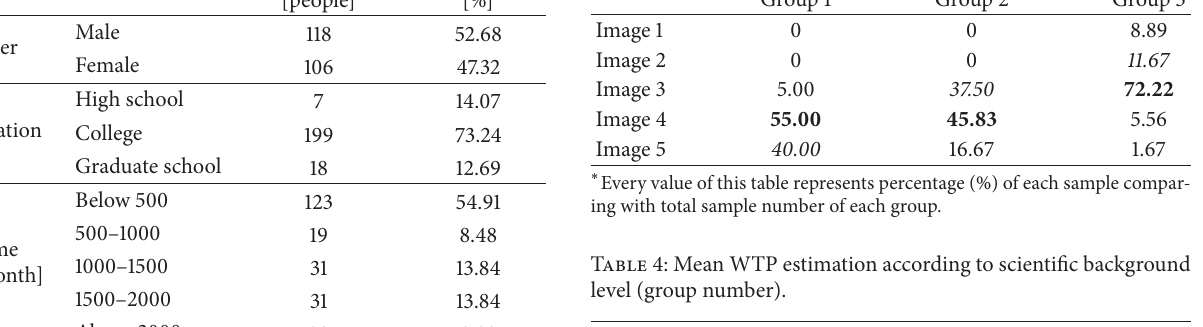
Table 1: Basic demographics of respondents. Characteristics